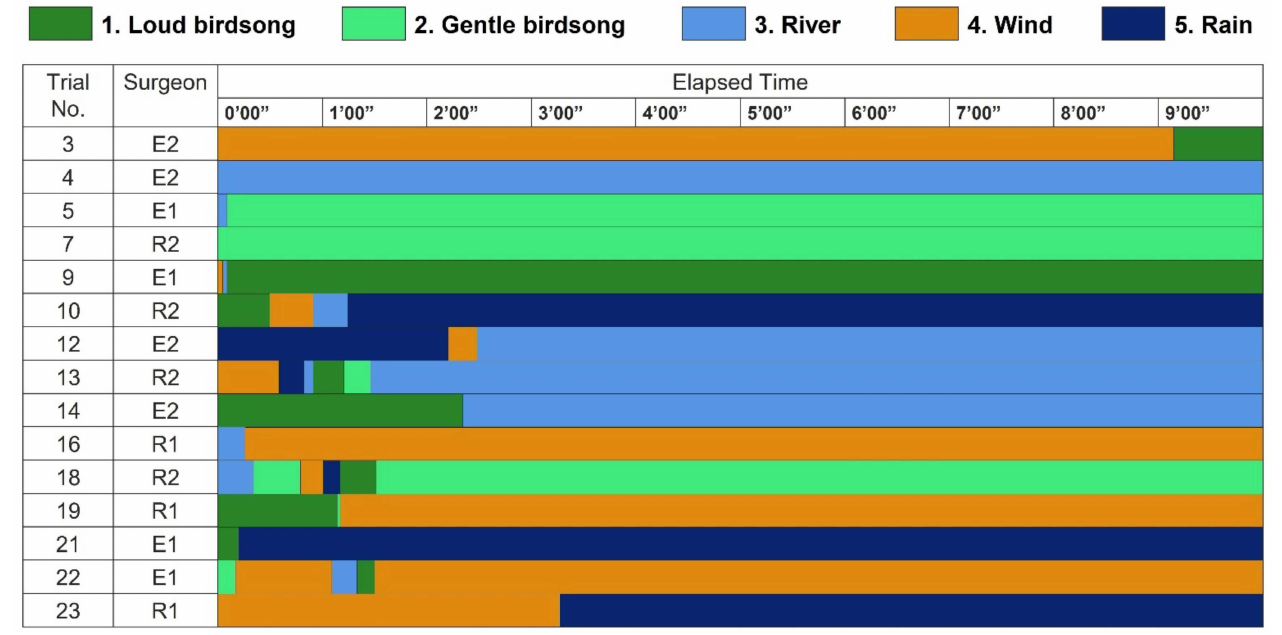
Figure 2. Surgeons’ patterns of listening to natural sounds.